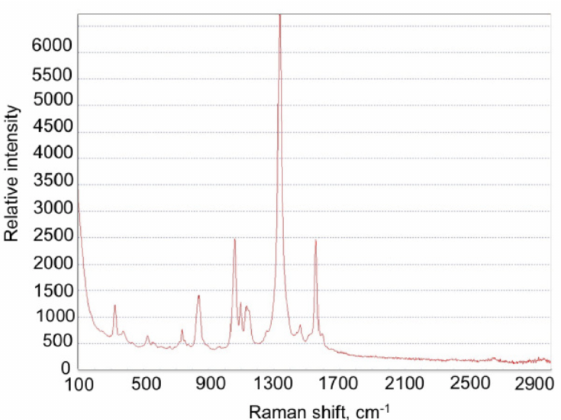
Figure 18. SERS intensity of AuNP-DTNB conjugates placed on PMMA bars (after normalization to the amount of gold nanoparticles as discussed in Figure 10), reprinted with permission from [16], the Optical Society